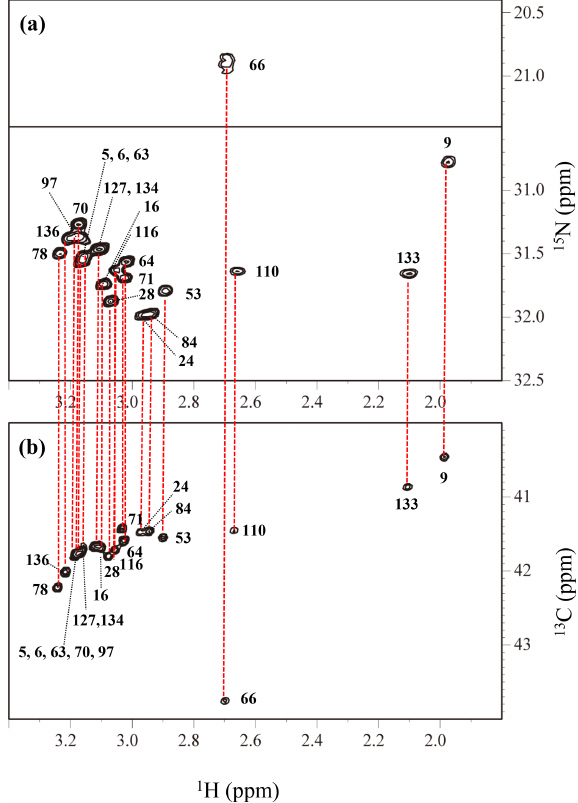
Figure A4. The HECENZ (a) and ct HSQC (b) spectra, recorded on a Bruker Avance 600 spectrometer ( 1 H, 600.0MHz; 13 C, 150.9MHz; 15 N, 60.8MHz) using 1.4mM D 2 O solutions of the (cid:49) + PHS/V66K SNase variants selectively labeled with SAIL-Lys, at 30 ◦ C, pD 8.0. Note that the chemical shifts of the 1 H and 13 C dimensions are referenced to DSS, while the 15 N dimension is ref- erenced to TSP: δ DSS – δ TSP = 0.15ppm. The detailed experimental parameters are discussed in Sect. 2.2.